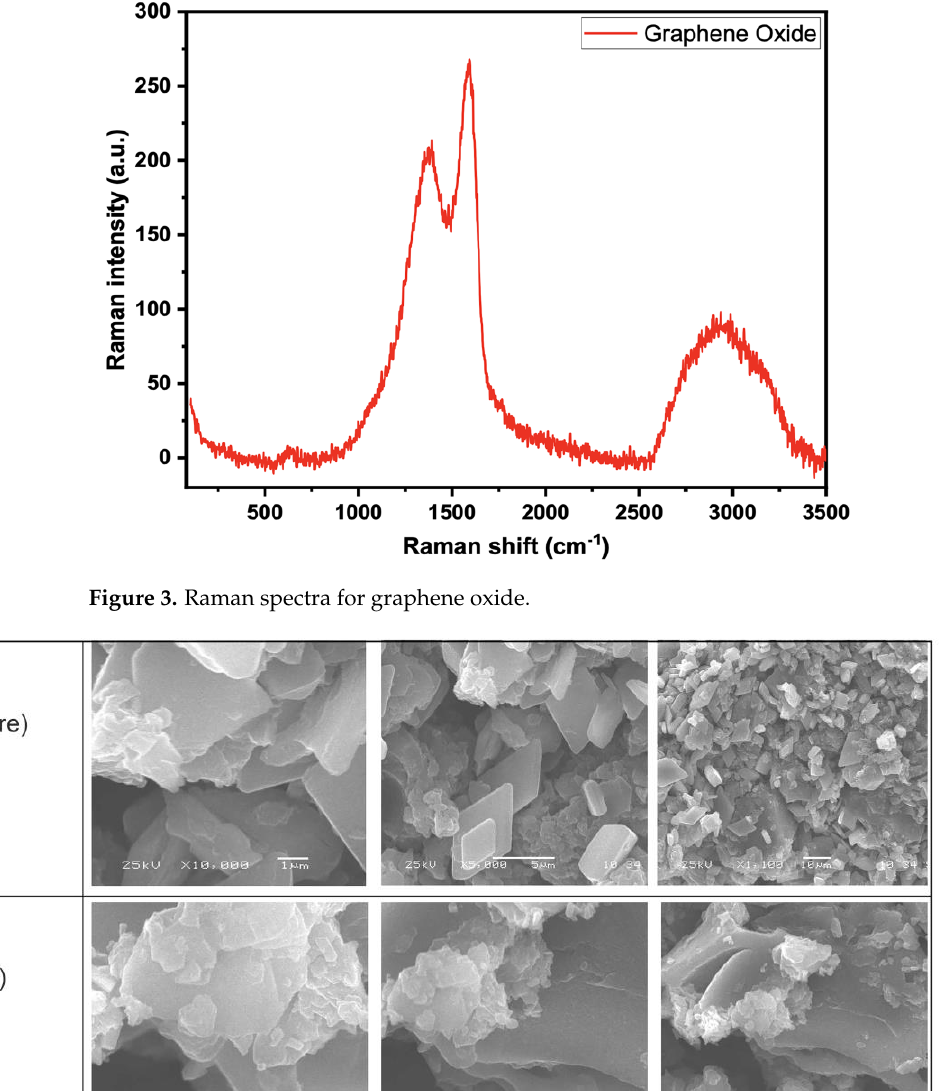
Figure 3. Raman spectra for graphene oxide.